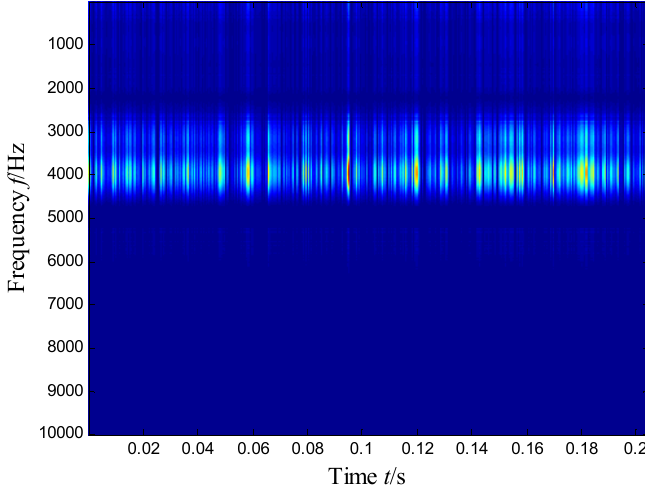
Figure 16. Selected time–frequency subspace for NMF.